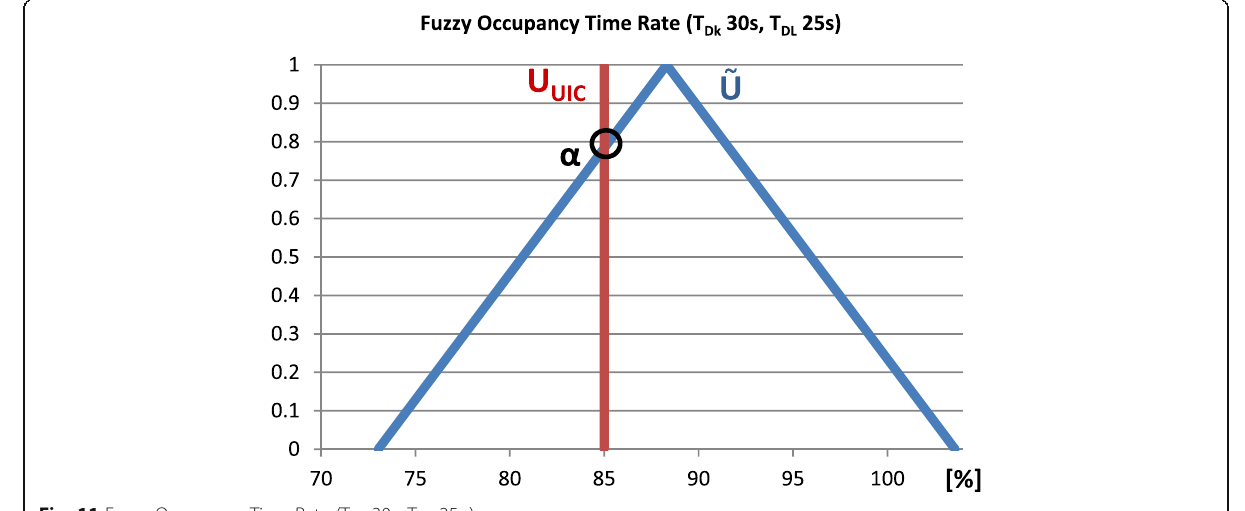
Fig. 11 Fuzzy Occupancy Time Rate (T Dk 30s, T DL 25